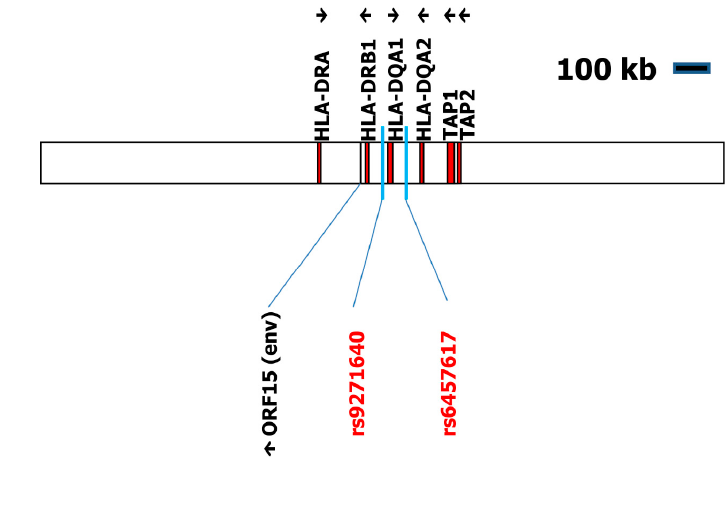
Figure 4. Schematic organization of the rs9271640/rs6457617 region at human chromosome 6. The 2,071,651 base pair region on human chromosome 6 flanking the rs9271640/rs6457617 region was analyzed for the presence of open reading frames (ORFs) with a minimal length of one kilobase by using getorf. 27 ORFs were identified (see Supplementary Table S5). These ORFs were analyzed using BLASTP against the database of retro-transcribing viruses (taxid 35268). One of the ORFs (ORF15) showed high homology to known sequences from retro-transcribing viruses. For a complete list of all genes in this chromosomal region, see Supplementary Table S6. TAP: transporter associated with antigen processing. HLA: human leukocyte antigen.